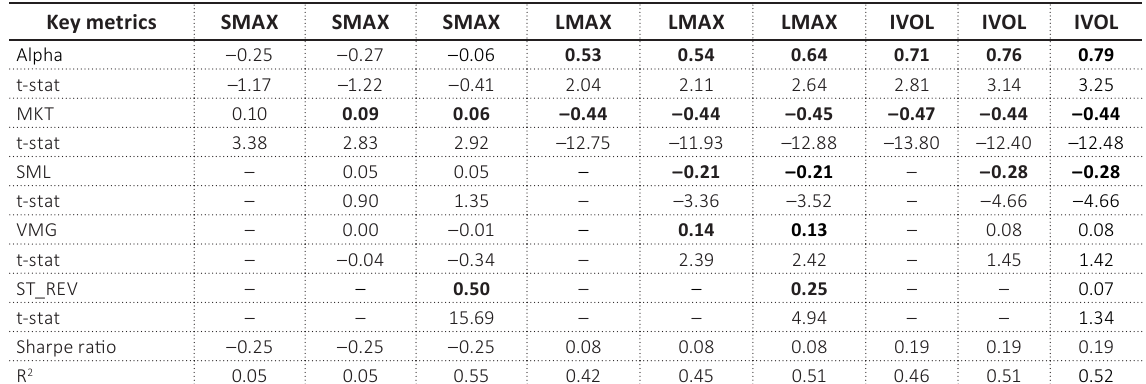
Table 8. The IDVOL risk factors